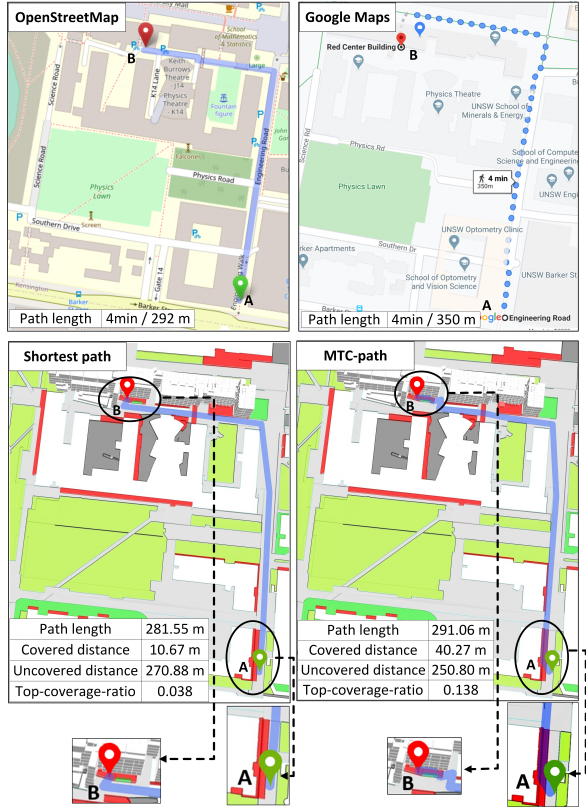
Figure 11. Navigation paths of A (cid:32) B. Differences between shortest path and MTC-path are marked by black ellipses, which shows where the sI-spaces are